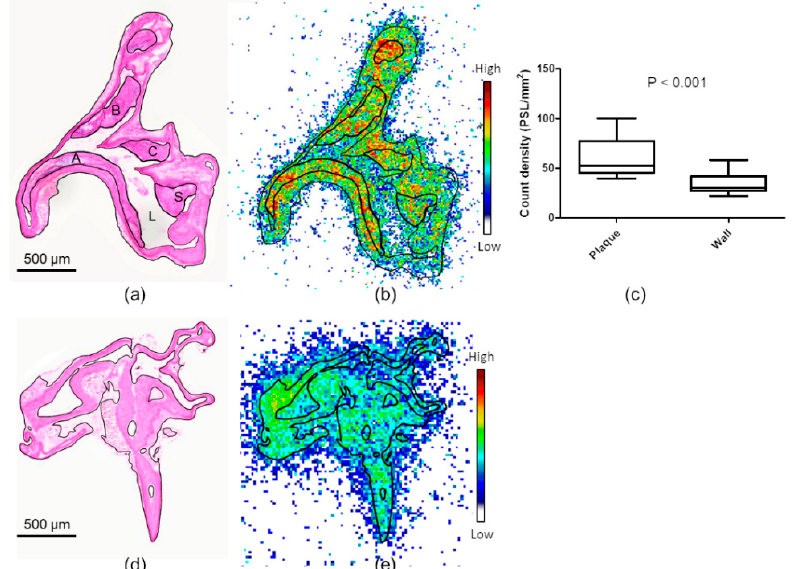
Figure 3. [ 18 F]Flutemetamol ex vivo autoradiography of mouse aortic sections. ( a ) Hematoxylin-eosin-